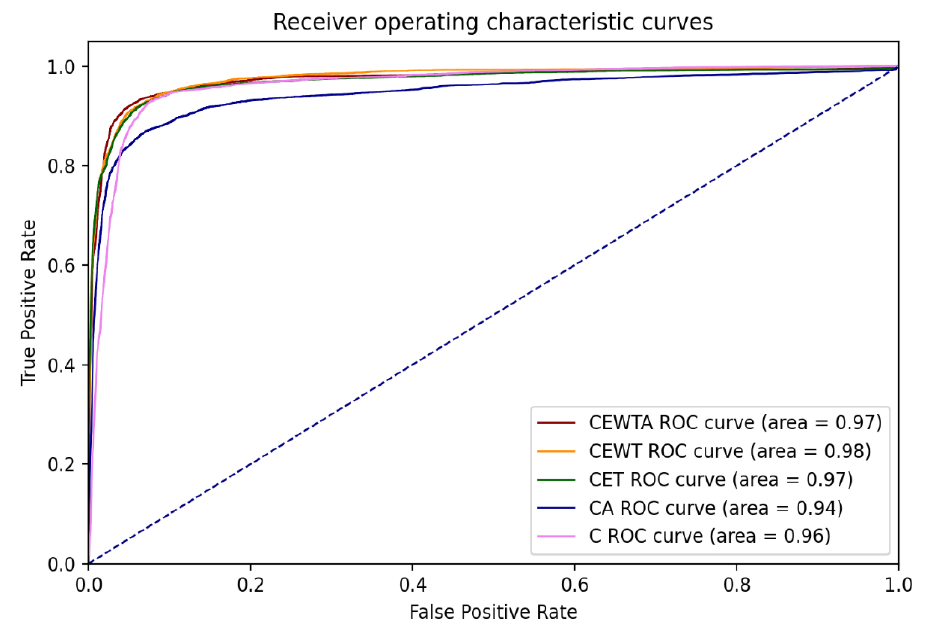
Figure 15. ROC curves and AUC values of the five